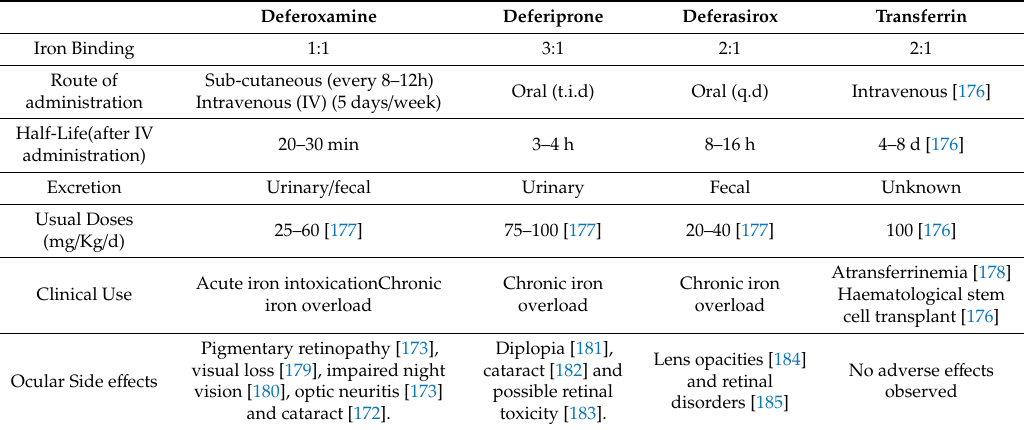
Legend Table 2: Tid: 3 times a day; q.d: once a